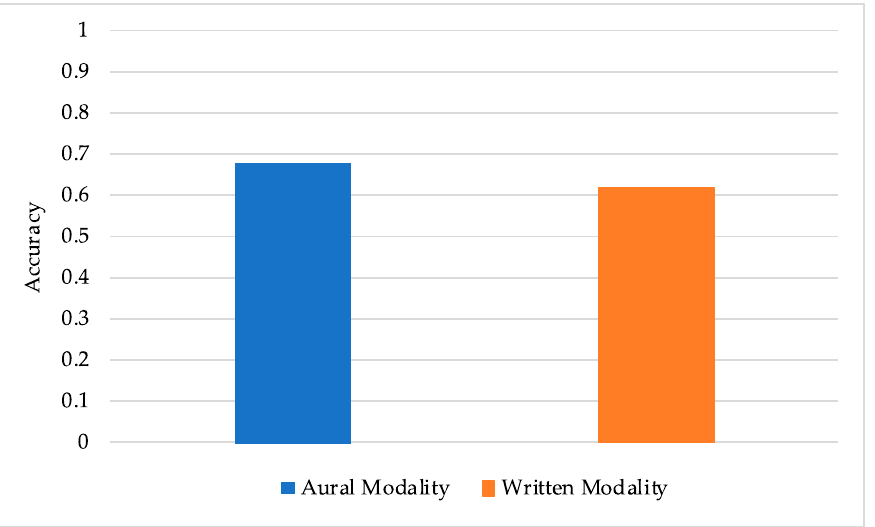
Figure 8. PMT: HL learners’ mean accuracy on comprehension of passive clauses by modality.